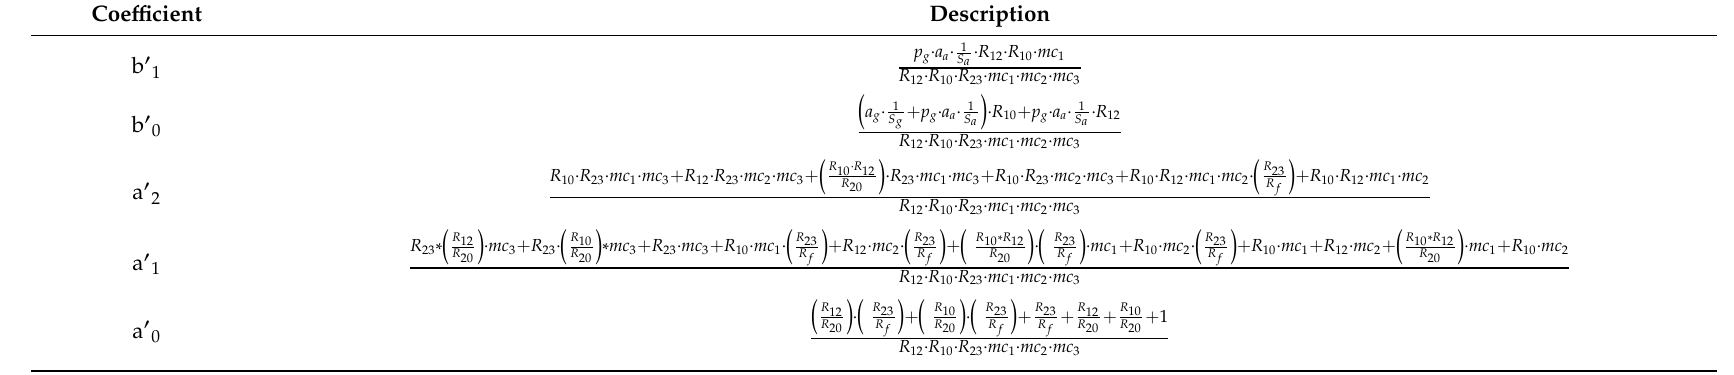
Table A4. Transfer function coe ffi cients of the second segment G 2 ( s ) =